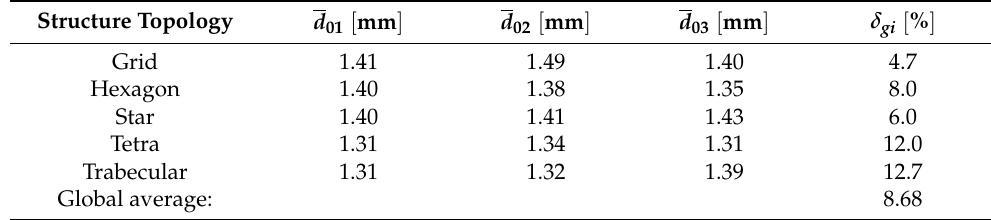
Table 3. Results of statistical analysis of beam diameter measurements of the tested topologies. Structure